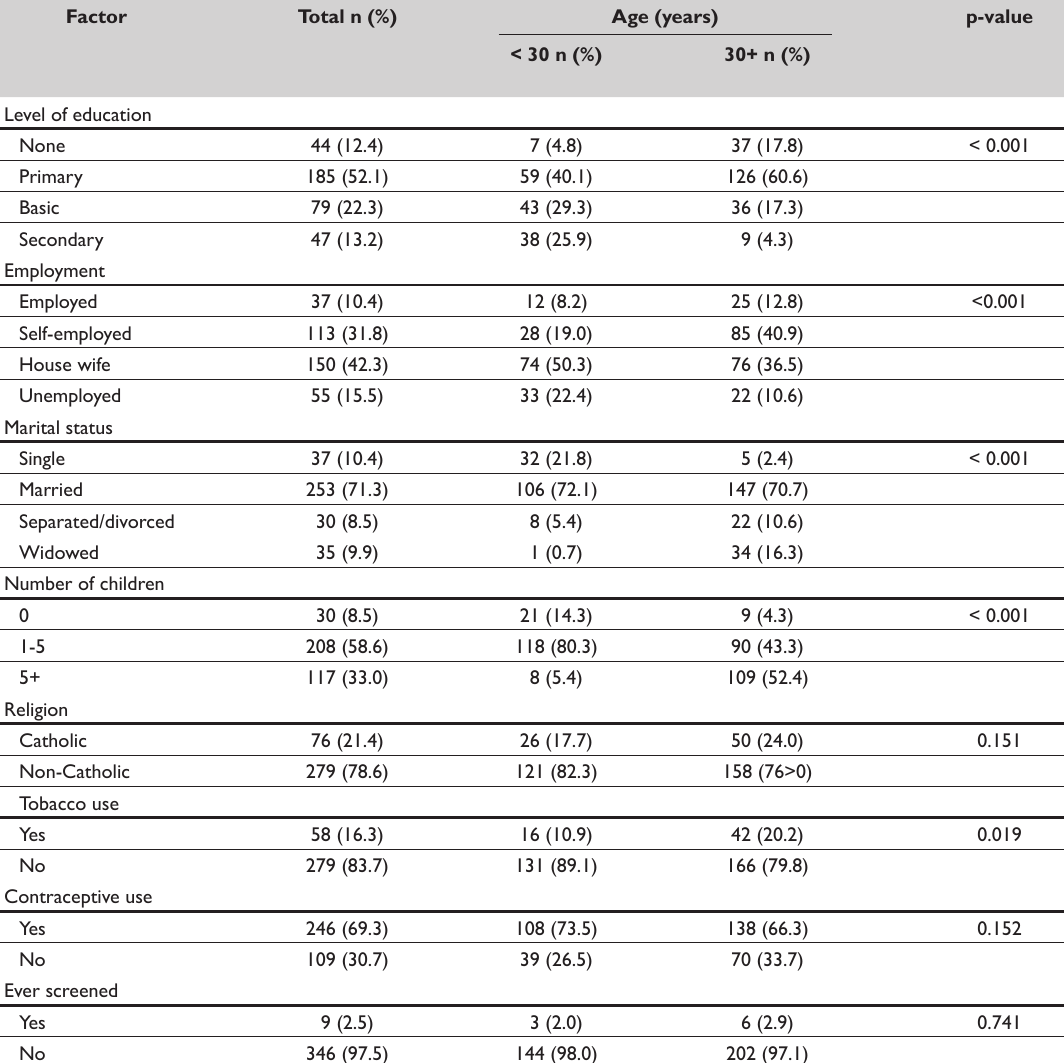
Table 1: Sociodemographic characteristics of the study